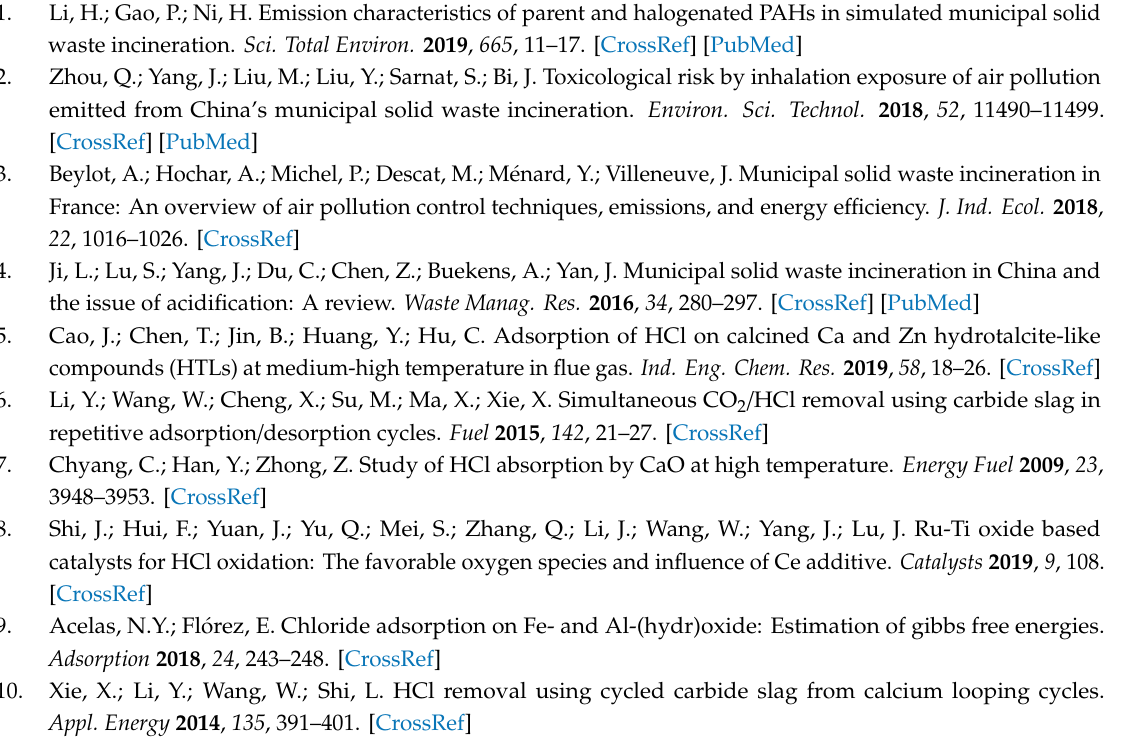
Table S1: BET Surface Area and Pore-size Distribution for CaMgAl-LDOs at di ff erent